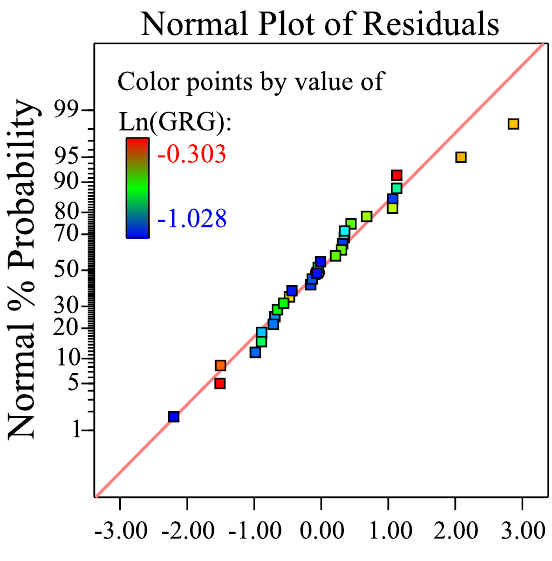
Figure 6. Normal plot of GRG